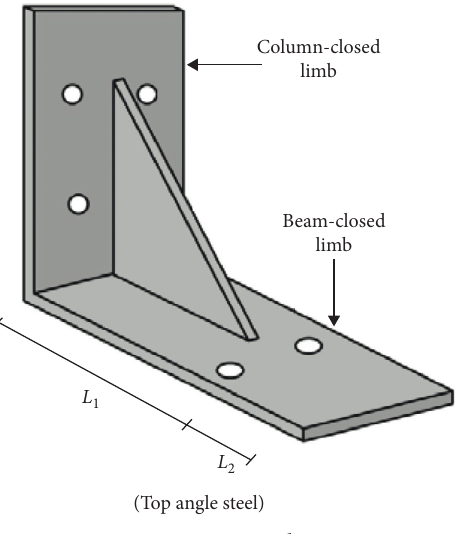
Figure 15: L 1 and L 2 . Table 5: Comparison of the predicted and experimental bearing